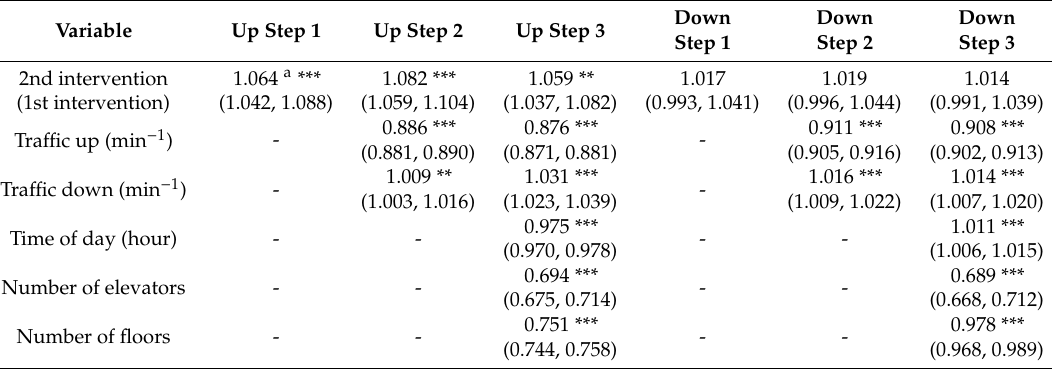
Table 3. Summary of the e ff ects of variables on stair use in the UK during the second intervention